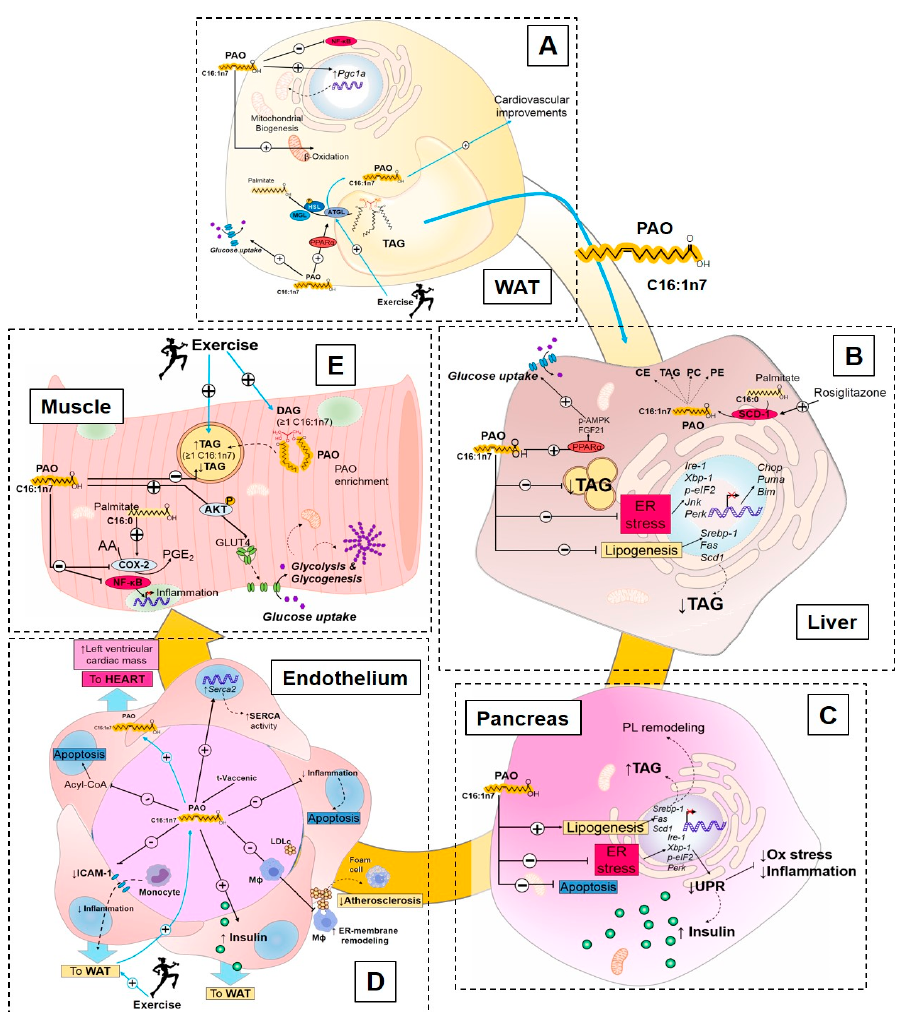
Figure 2. Endocrine effects of Palmitoleate. ( A ) Palmitoleate (PAO) is synthesized and stored in adipose tissue in TAG. Upon lipolytic stimulation (exercise, in blue), PAO is released and secreted to act in an autocrine or endocrine way. PAO can act in adipose to decrease inflammation (NF-kB), increase mitochondrial biogenesis (Pgc-1a), and β -oxidation. PAO can increase lipolysis and improve glucose uptake. ( B ) In the liver, PAO can directly stimulate glucose uptake through an AMPK/FGF21 mechanism. It can reduce steatohepatitis by reducing lipogenic gene expression and decrease endoplasmic reticulum (ER)-stress. In liver, insulin sensitizer rosiglitazone enhances desaturation and PAO enrichment in cholesteryl-ester (CE), TAG, and phospholipid portions (PC and PE). ( C ) In pancreatic β -cells, PAO leads to lipogenesis activation, decreased ER-stress, and apoptosis, which contribute to the improvement of β -cell endocrine function. Increase lipogenic genes in β -cells leads to phospholipid remodeling that results in pancreatic protection and insulin release. ( D ) In endothelial cells, PAO improves ER pump Sarcoplasmic/Endoplasmic Reticulum Calcium ATPase 2 ( Serca2 ) expression and SERCA activity, which decreases Acyl-CoA accumulation and inflammation that leads to reduced apoptosis. PAO improves macrophage (M ϕ ) membrane-lipid remodeling and reduced atherosclerosis. PAO can also enhance insulin delivery to WAT and decrease monocyte adhesion and recruitment to AT. Exercise (in blue) leads to AT lipolysis and PAO secretion, which, in turn, contributes to PAO delivery to the heart and contributes to cardiometabolic improvements. ( E ) PAO reduces inflammation and oxidative stress in skeletal muscle, and, through AKT phosphorylation, it improves glucose uptake. PAO also leads to reduced intramyofibrillar TAG accumulation, and exercise (in blue) contributes to PAO enrichment in TAG and DAG in muscle.